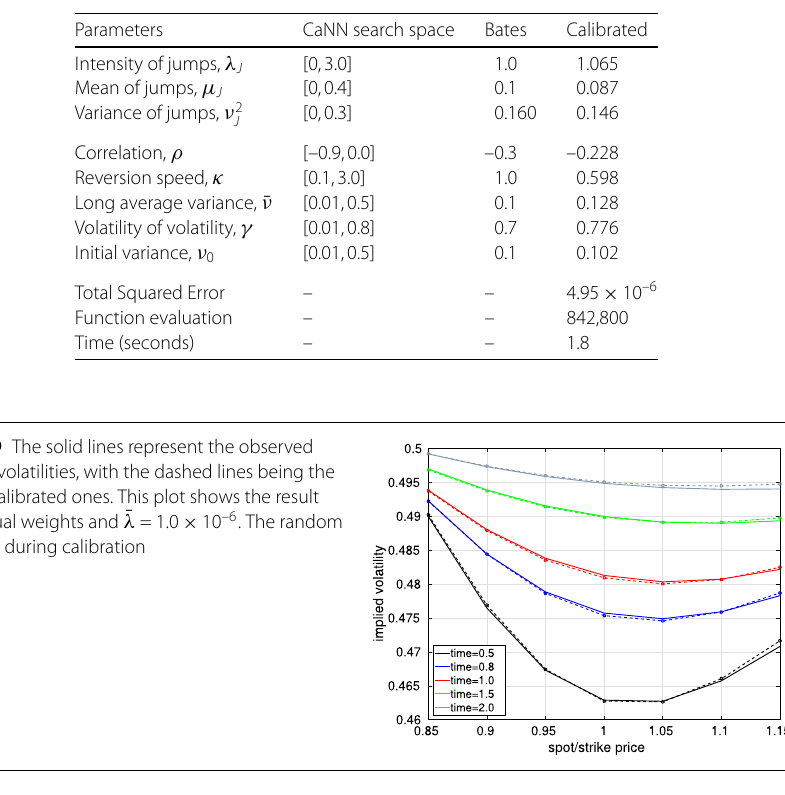
Table 11 The Bates parameters are estimated with Bates–CaNN, by calibrating to a data set (35 samples) generated by the Bates model. In DE, the random seed is 2 and the population size is 10 × N v = 80